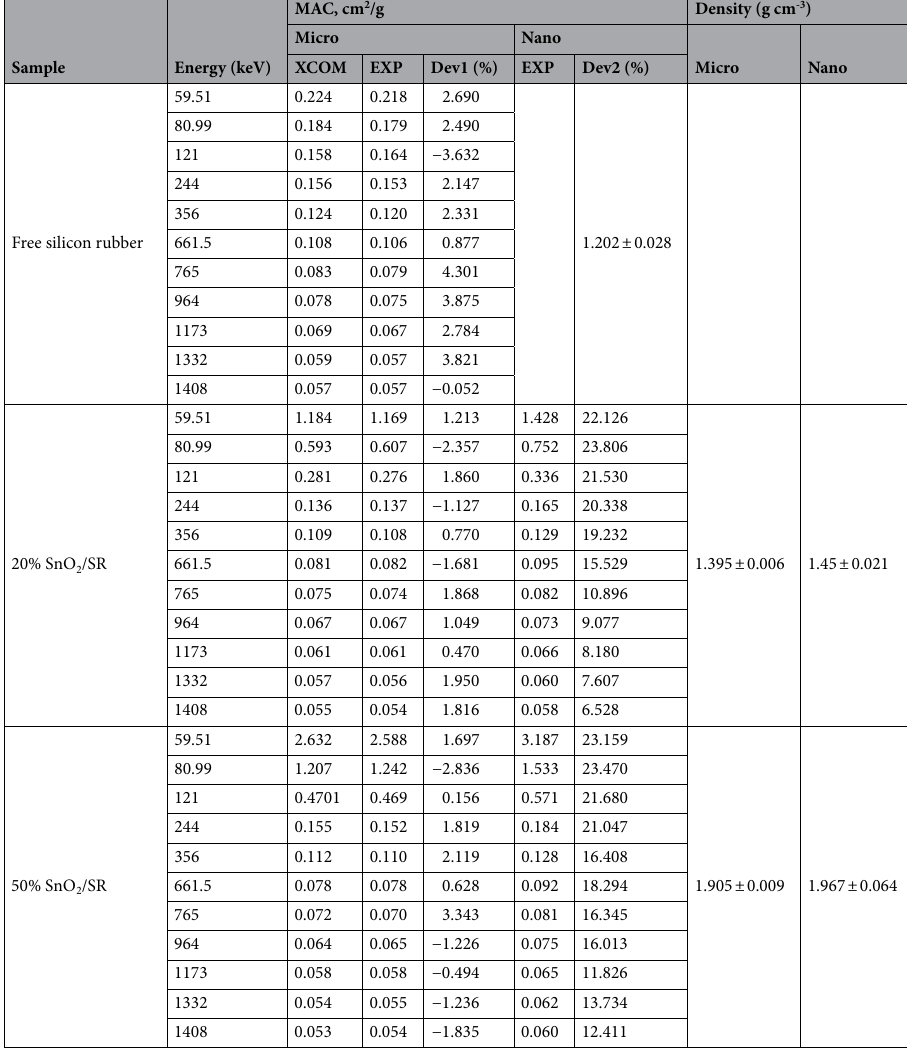
were measured to evaluate the effectiveness of the weight fraction of additive material and their size scale on the shieling behavior of composites. From Fig. 8, it is observed that, MAC values depend on density for free silicon rubber and SnO 2 /SR at different concentrations and different scales. Figure 8 and Table2 show that, the density of silicon rubber composites increases as the percentage of tin oxide in composites increases, due to their high atomic number and density. Also, composites filled with nano particles have higher density than composites filled with micro at the same weight fraction, which led to increased shielding properties of nano composites than micro composites. There is a high linear correlation coefficient between density and shielding properties such as linear attenuation coefficient. The variation results of HVL and TVL are shown in Fig. 9, where HVL and TVL results increase with increasing gamma ray energy gradually at all composites. Free silicon rubber has lower HVL and TVL than the